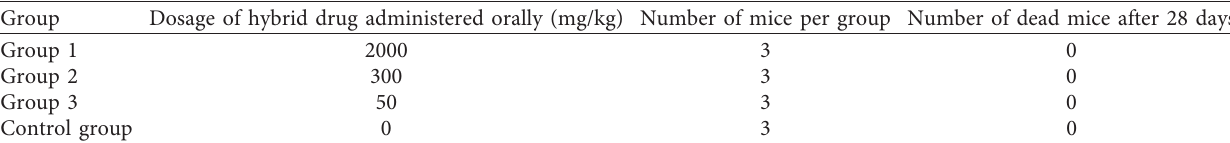
Table 5: Acute toxicity in mice following different dosage administrations.